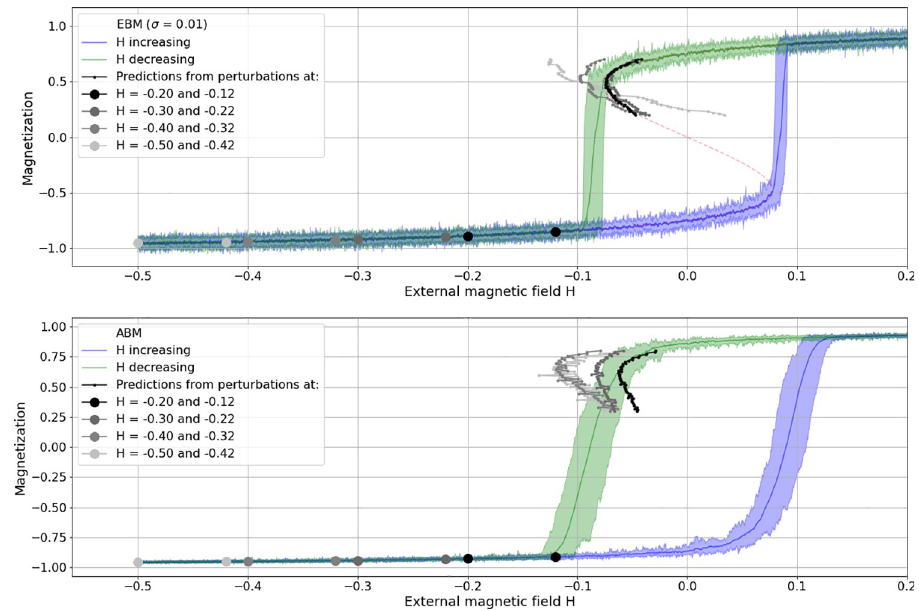
Fig 4. Prediction comparison for the combined saddle-node bifurcation. Comparison for the combined saddle- node bifurcation predictions from perturbations, applied at the lower before-transition range of magnetization on EBM-generated data (top row) and ABM-generated data (bottom row). Light-grey to black dots indicating perturbation parameters, light-grey to black dotted curves indicating corresponding predictions.